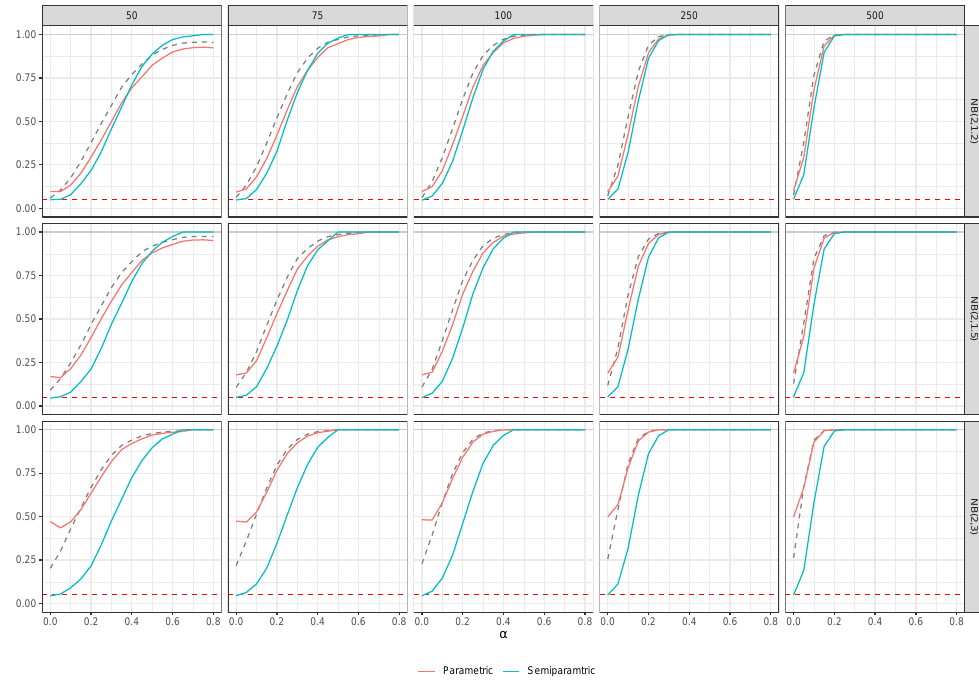
Figure 3. Empirical power of the bootstrap-based score test under negative binomial DGP. The black dashed line is the empirical power of the asymptotic test, while the red dashed line represents the nominal level of 0.05.